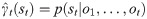
Posterior probabilities of the HMM.Comparison of the filtering posterior γ^t(st)=p(st|o1,…,ot) of the different HMM inference models for an example sequence. The true, but unknown regimes of the data generation process are plotted in red. Note that, as the regimes were balanced in terms of stimulus probabilities, SP inference is not able to capture the underlying regimes and instead attempts to dissociate two states based on empirical differences in observed stimulus probabilities.